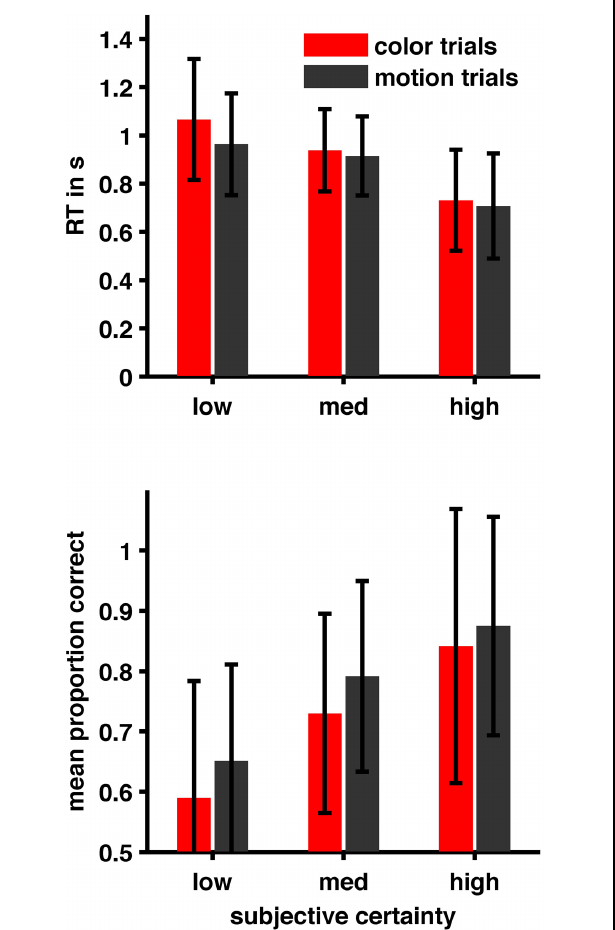
FIGURE 2 | Relation between subjective certainty ratings, performance, and reaction time. Performance increases with subjective certainty while RT decreases (see also Results section and Table 1